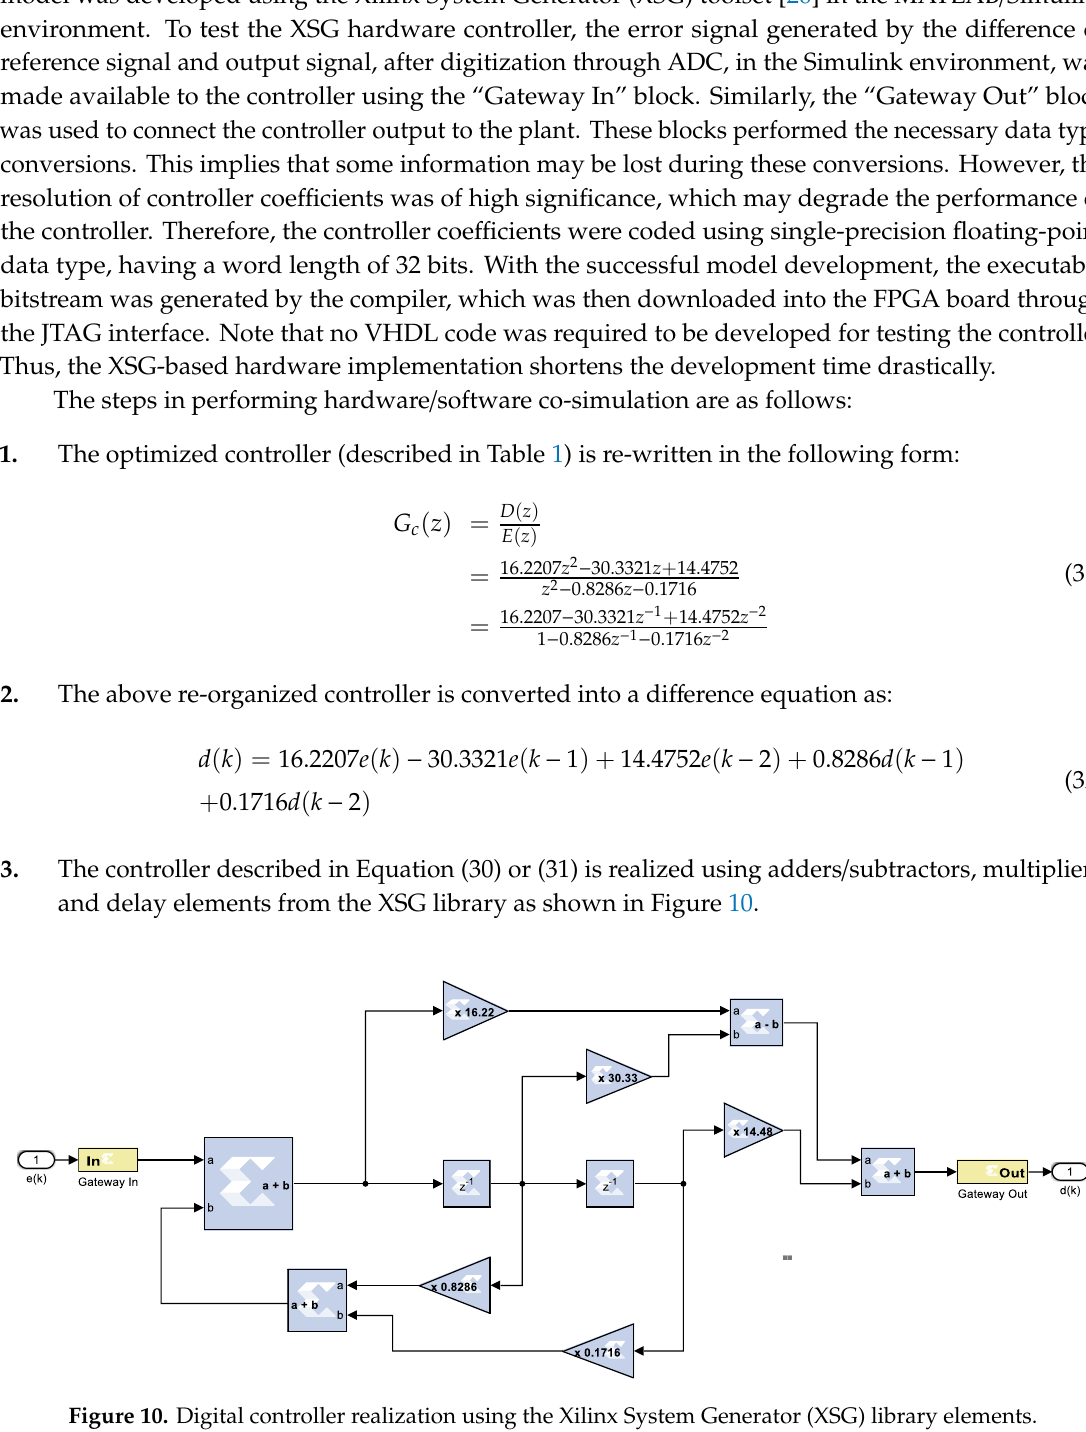
Figure 10. Digital controller realization using the Xilinx System Generator (XSG) library elements.